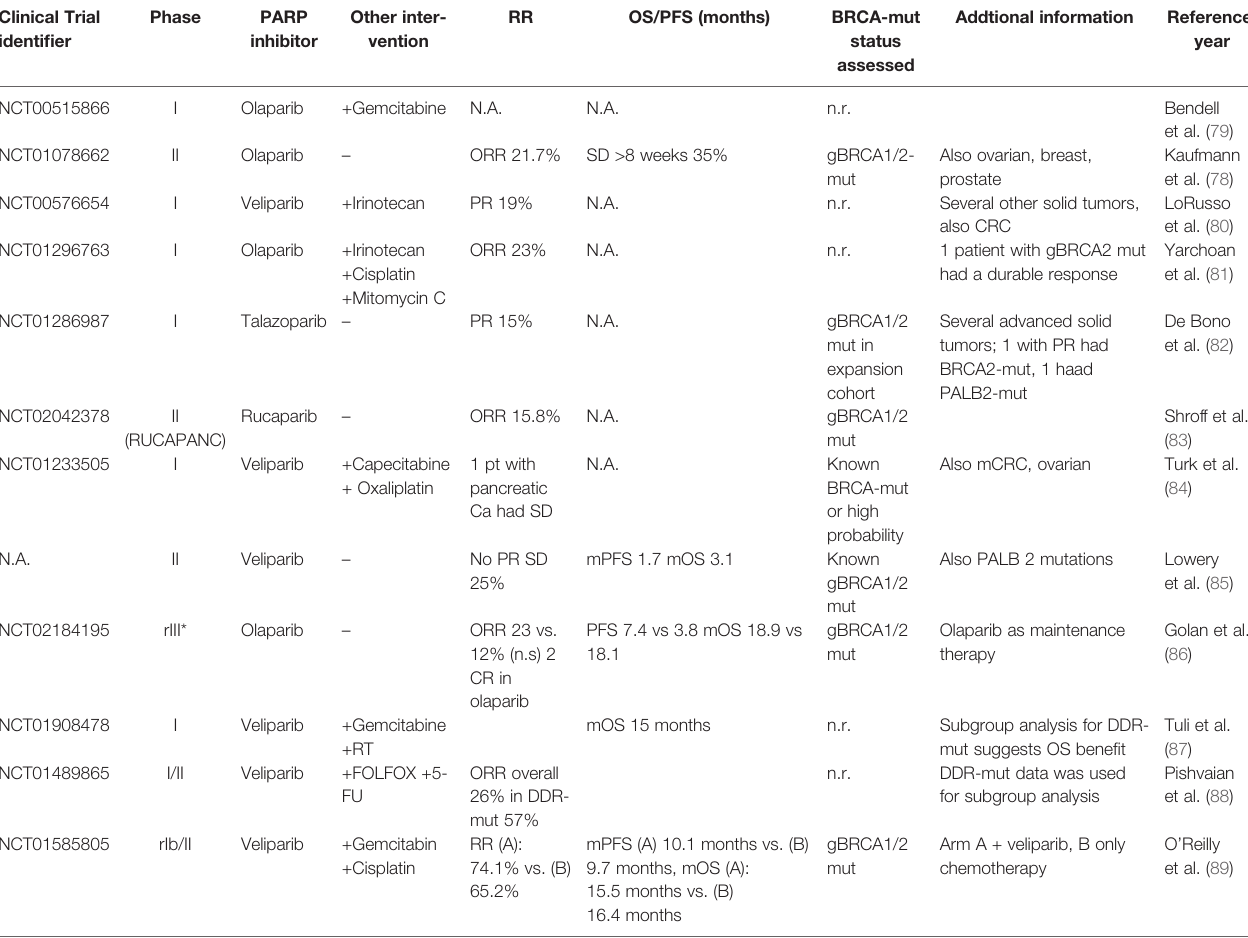
TABLE 2 | Published clinical trials using PARP inhibitors in pancreatic cancer. Clinical Trial identi fi